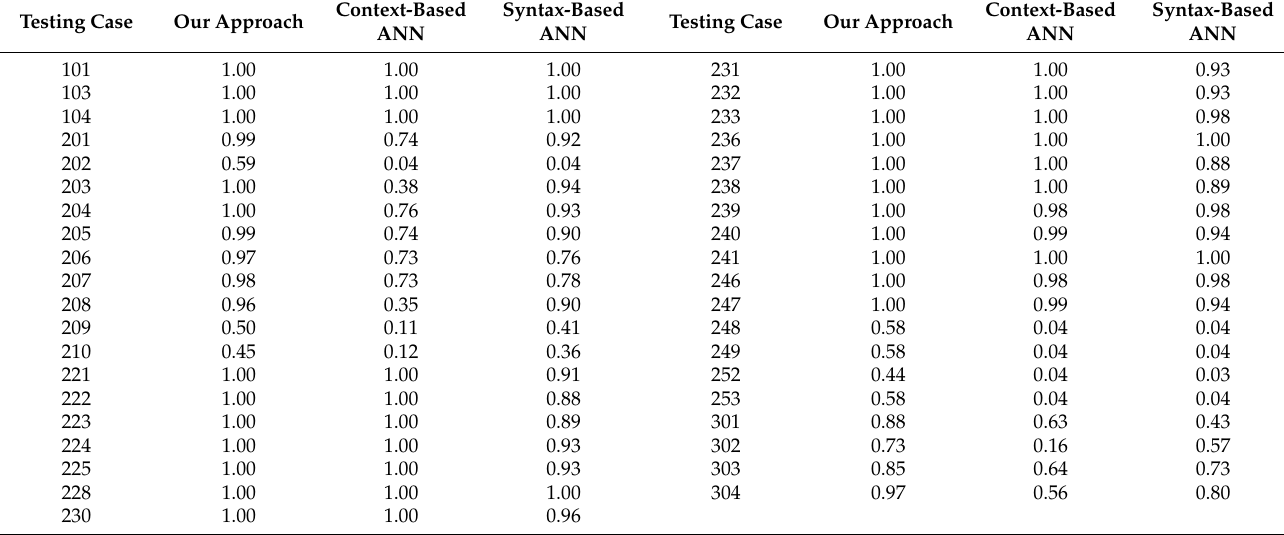
Table 9. Comparison With ANN-based Matching Techniques On OAEI’s